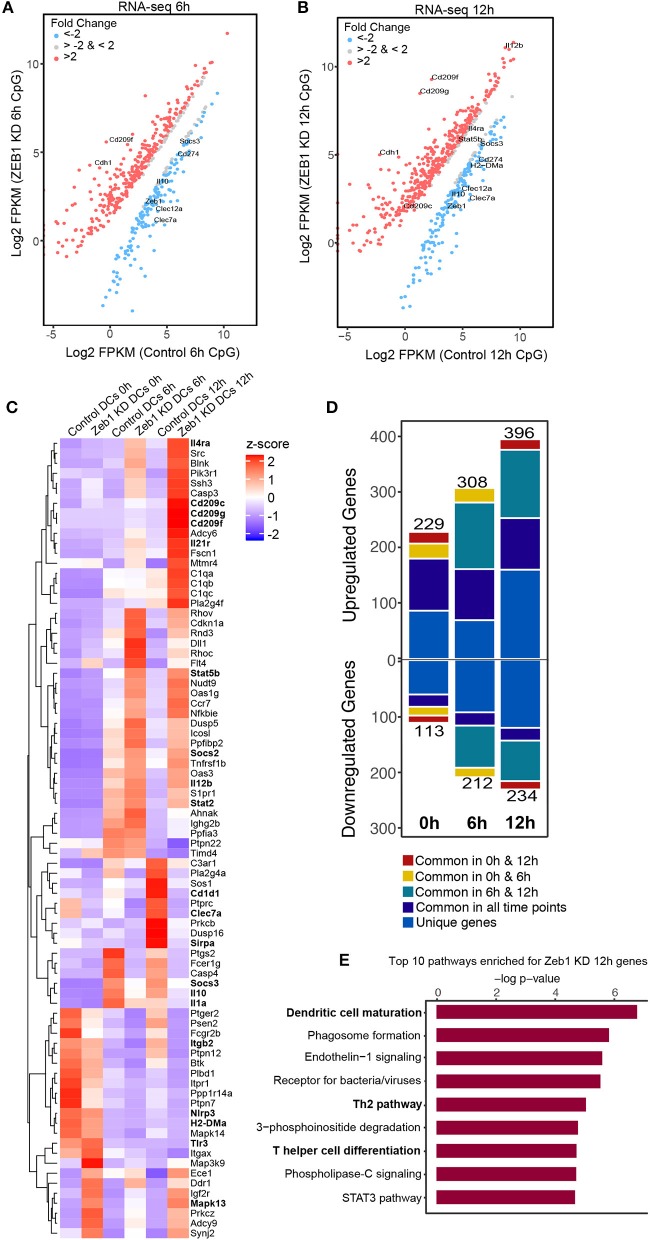
Global transcriptome analysis of Zeb1 KD cDC1 MutuDCs showed enrichment of pathways involved in T helper cell differentiation and Th2 pathways. Two independent biological replicates with three time points (0, 6, 12 h) were used for this analysis. (A) RNA-seq scatter-plot showing the differentially regulated genes in Zeb1 KD cDC1 MutuDCs as compared to control DCs at 6 h after CpG activation n = 2. (B) Scatter-plot showing the differentially regulated genes in Zeb1 KD cDC1 MutuDCs as compared to control DCs at 12 h after CpG activation n = 2. (C) Heat-map generated from a list of manually curated genes identified from differentially regulated gene list in Zeb1 KD RNA-seq data, which includes the genes that are reported to induce Th2 responses upon activation by DCs. Major DC response genes found to be predominantly regulated after Zeb1 KD are highlighted in bold. To generate this bar-graph Z-score was calculated for each gene from normalized FPKM values to demonstrate the differential regulation of genes in control and Zeb1 KD DCs at 0, 6, and 12 h after CpG activation. (D) Bar-plot depicting the number of genes differentially regulated in Zeb1 KD DCs at 0, 6, and 12 h CpG activation as compared to control DCs. Different color codes indicate the genes that are unique or similar in the list of differentially regulated genes at different time points (0, 6, and 12 h). (E) Bar-plot depicting the biological pathways that were significantly enriched for the genes that differentially regulated after Zeb1 KD in 6 and 12 h CpG activation as compared to control cells. Ingenuity Pathway Analysis (IPA) was used to perform pathway enrichment analysis.